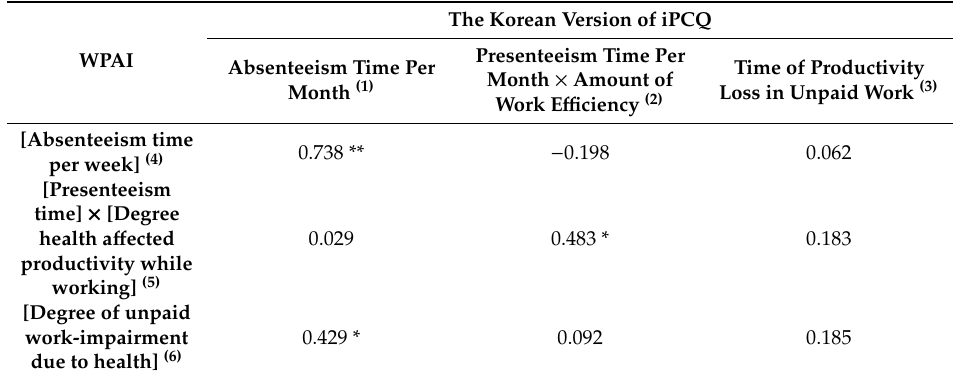
Table 4. Concurrent validity results using the Spearman’s rank